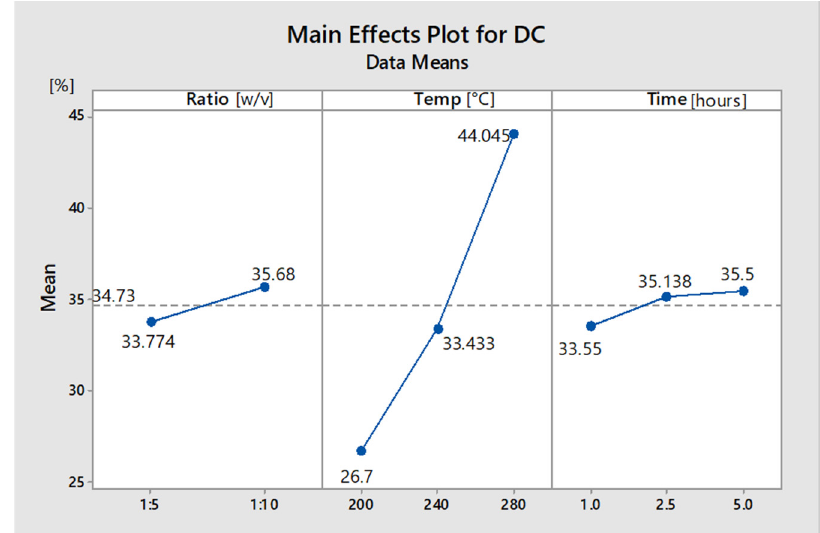
Figure 2 highlighted the influence of the three independent parameters with a direct influence on the conversion degree. The increase of their value leads to the increase of the conversion degree. Thus, as the temperature rises in the range of 200–240 ◦ C, the conversion degree increases slowly, whereas an increase in temperature in the range of 240–280 ◦ C causes a considerable enhancement of conversion degree. In terms of residence time, the conversion degree is relatively similar in the range of 1–2.5 h and the range of 2.5–5 h.